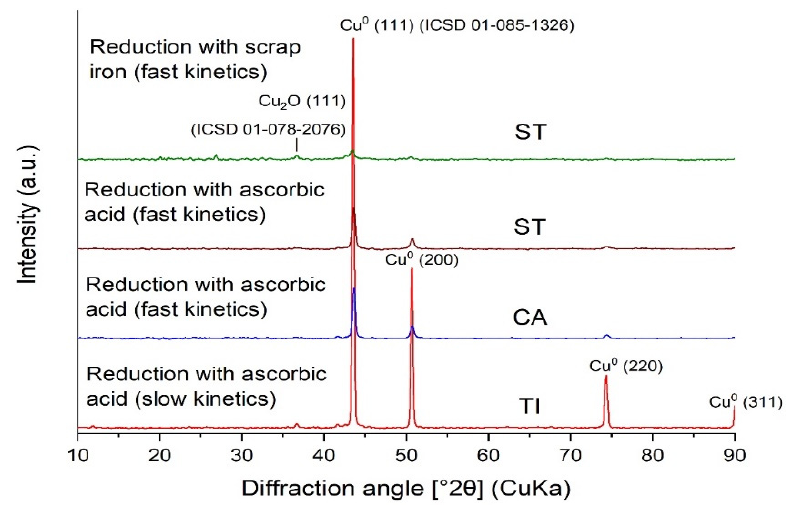
Figure 2. XRD patterns of Cu[0] obtained in the different batch experiments conducted in this study: (I) large Cu[0] crystals formed by reduction of Cu(II)-rich solutions with ascorbic acid 10 mM at pH 3.95 and 25 °C (TI; bottom), (II) Cu[0] nanoparticles formed by reduction with ascorbic acid 0.1 M at pH 3.95 and 80 °C (CA, ST; center), and (III) Cu[0] nanoparticles formed by reduction with Fe[0] (scrap iron) at pH 1.5 and 25 °C (ST; top).